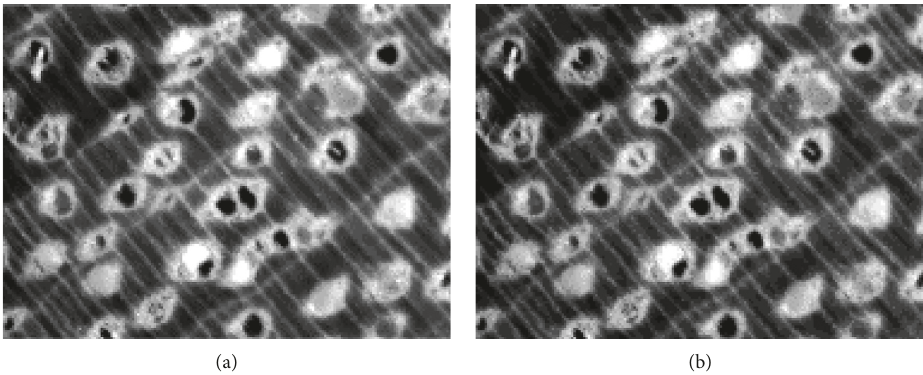
Figure 18: Results of dimensionality reduction from PCA ((a) PC1, (b) PC2, (c) PC3, and (d) PC4).